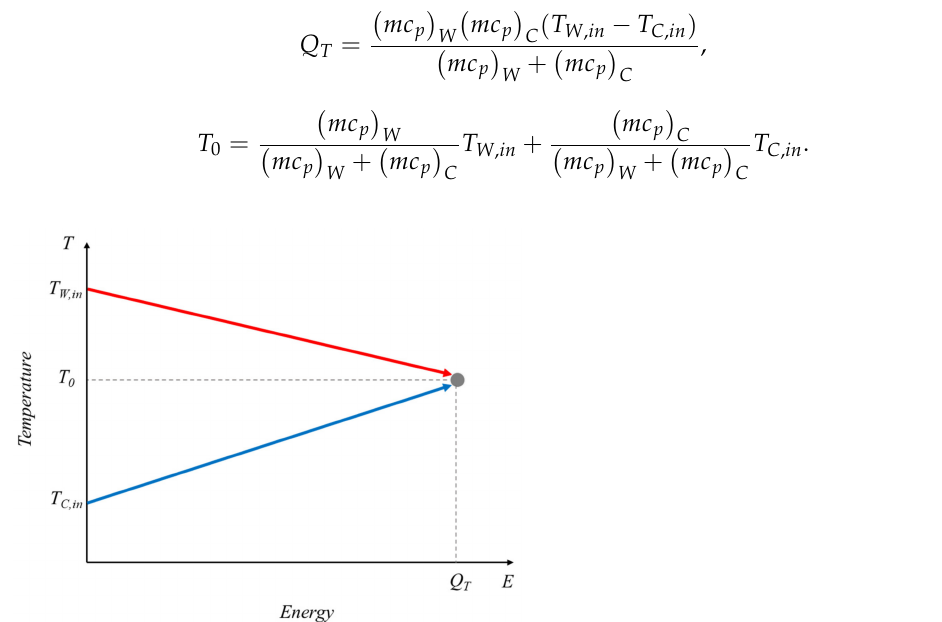
Figure 3. T – E diagram of seawater without energy conversion. Under the constant total mass flow rate of seawater as a design constraint, Q T is maximized when the balance of surface seawater and deep seawater heat capacities are equal,